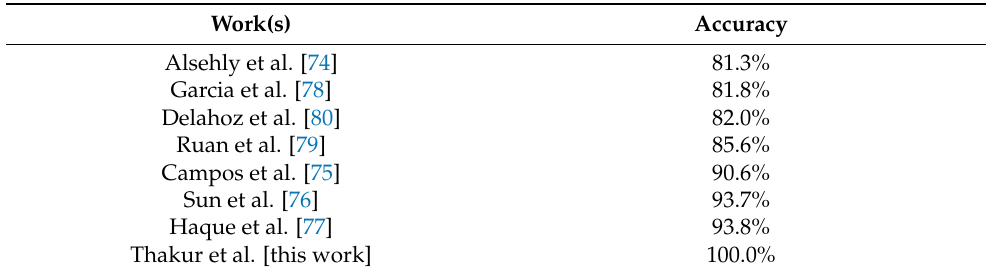
Table 8. Comparison of the indoor floor detection functionality in our framework with recent works in indoor floor